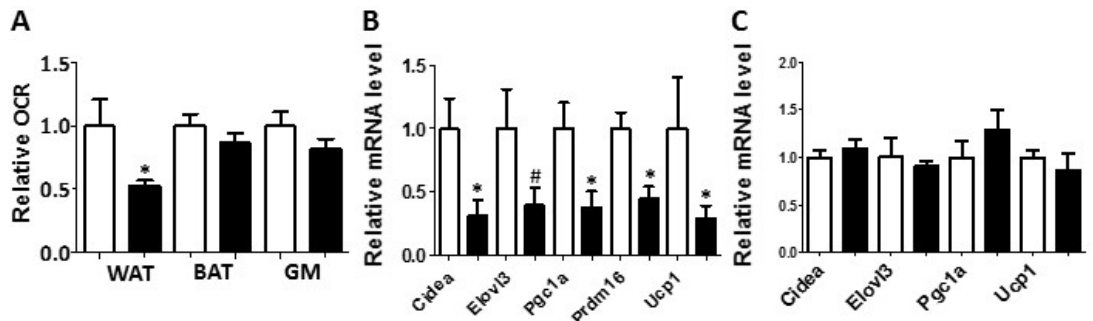
Figure 3. White adipose tissue collected from the PON2-def mice exhibited a decreased oxygen consumption rate and decreased mRNA levels of gene markers for beige adipocytes. ( A ) Relative oxygen consumption rates of subcutaneous fat pads (WAT), brown adipose tissue (BAT) and gastrocnemius muscle (GM) isolated from mice fed the obesifying diet for 8 weeks are shown. n = 6 for each group. Gene expression analyses of subcutaneous fat pads ( B ), and BAT ( C ) collected from mice fed the obesifying diet are shown. n = 6 for each group. #: p = 0.085, *: p < 0.05, vs. WT group.